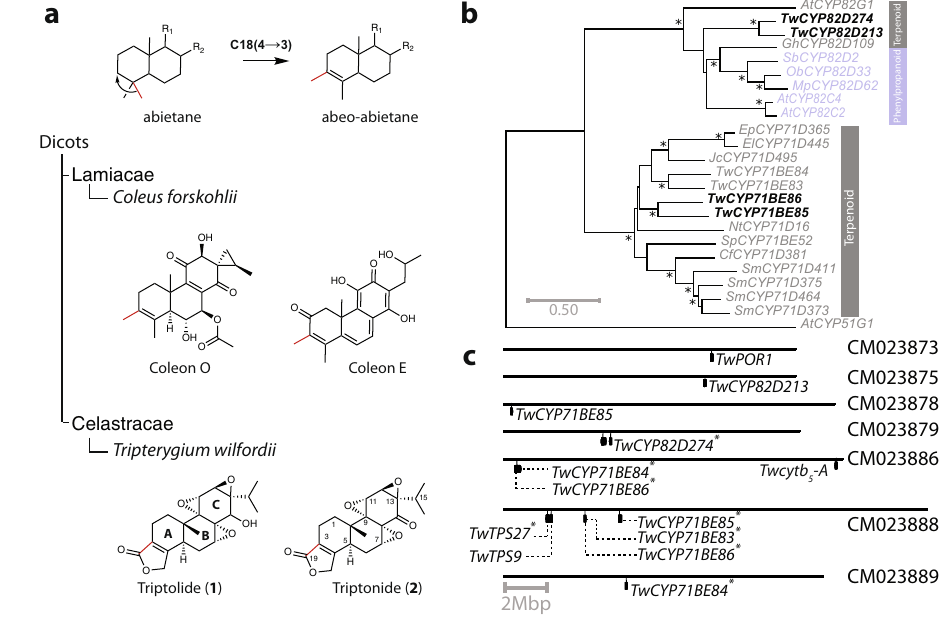
Fig. 1 | 18(4 → 3) abeo-abietane methyl shift. a Hypothesized scheme for the rearrangement of methyl groups on the A-ring of labdane type diterpenoids and examplesof diterpenoidswiththe18(4 → 3)abeo-abietane corestructure.Examples of labdane type diterpenoids from the Lamiaceae species Coleus forskohlii and the Celastracaespecies T.wilfordii withanabeo-abietanecorestructureareshown.The rings of the tricyclic corestructurearedenoted A,B,andC. b Maximum-likelihood phylogeneticanalysisof selectedCYPgenes from the 71 clan, including plant CYPs from the CYP82 and CYP71 subfamily, and Nt CYP51 as the root. Shown CYPs are involved in either phenylpropanoid (purple) or terpenoid (grey) biosynthesis